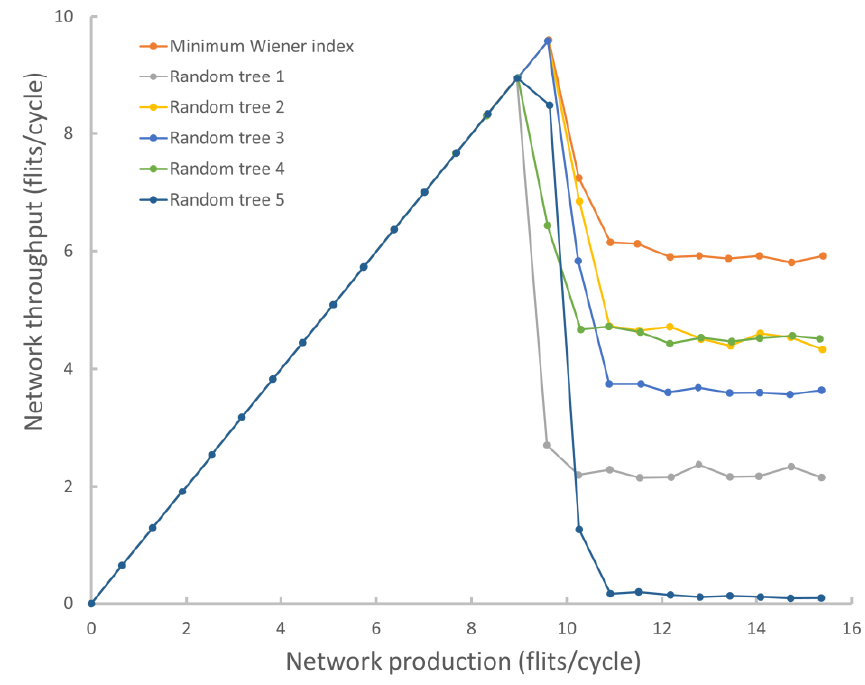
Figure 4. Comparison of different trees as a subnetwork to bypass deadlocks.